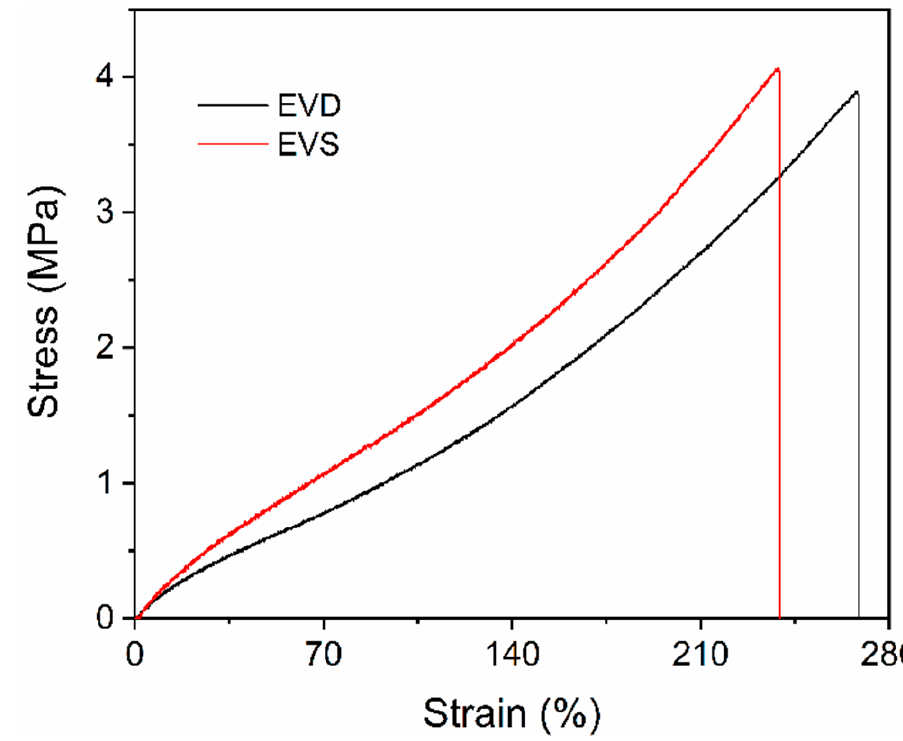
Figure 5. Stress-strain curves of EVD and EVS recorded at 40 °C.